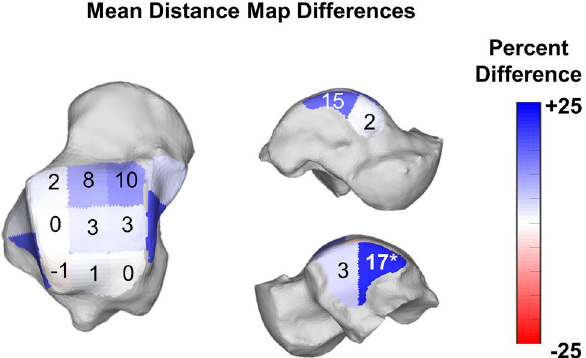
Figure 5. Average percent differences on Distance Maps for the nine zones of the talar dome as well as anterior and posterior aspects of the medial and lateral gutters of the ankle joint. Progressive Collapsing Foot Deformity (PCFD) minus Controls. Blue, white and red tones represent relative distances that are respectively higher, similar and smaller in PCFD patients. Bolded/starred regions denote significant changes ( p value of the difference <